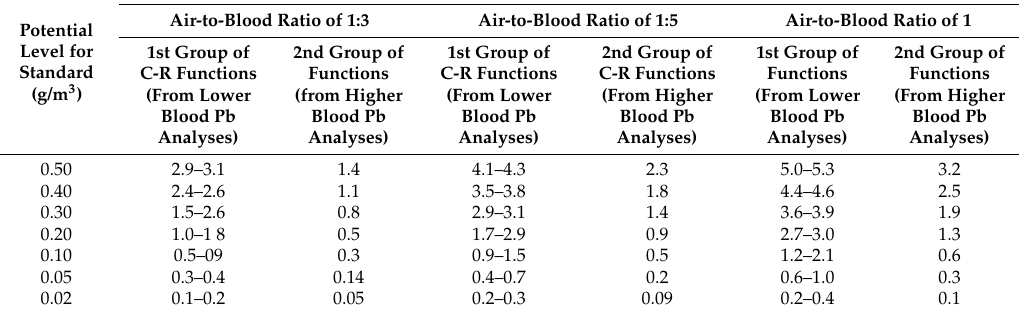
Table 2. Estimates of air-related population mean IQ loss for children exposed at the level of the standard. 1 These estimates were derived using only the nonlinear C-R function from the risk assessment which, given its nonlinearity, is considered to better assess risk across the range that includes extending into these higher standard levels (and the associated higher blood Pb